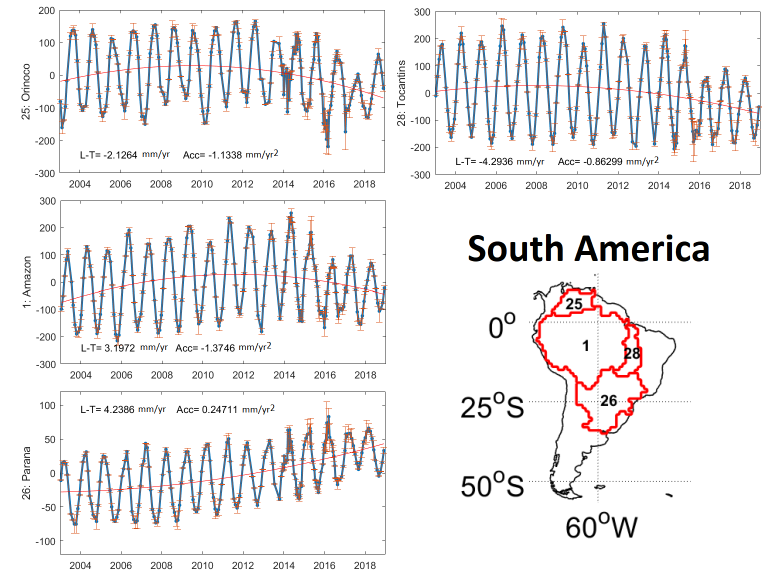
Figure 8. Basin averages of the reconstructed TWSC fields within the four major river basins of South America covering 2003–2018. The red line shows the long-term linear trend (L-T (mm/yr)) and acceleration (Acc (mm/yr 2 )) components fitted to the reconstructed TWSC